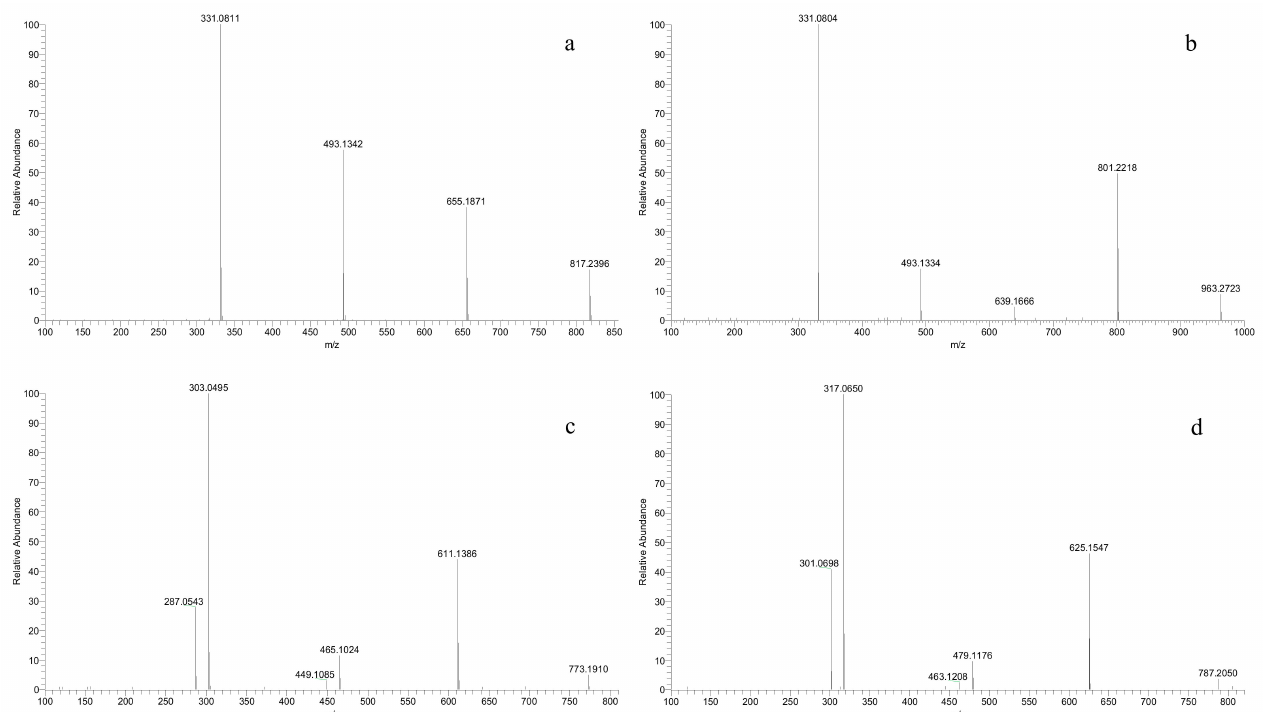
Figure 3. MS 2 spectrum of the ion signals m / z 817 ( a ), 963 ( b ), 773 ( c ) and 787 ( d